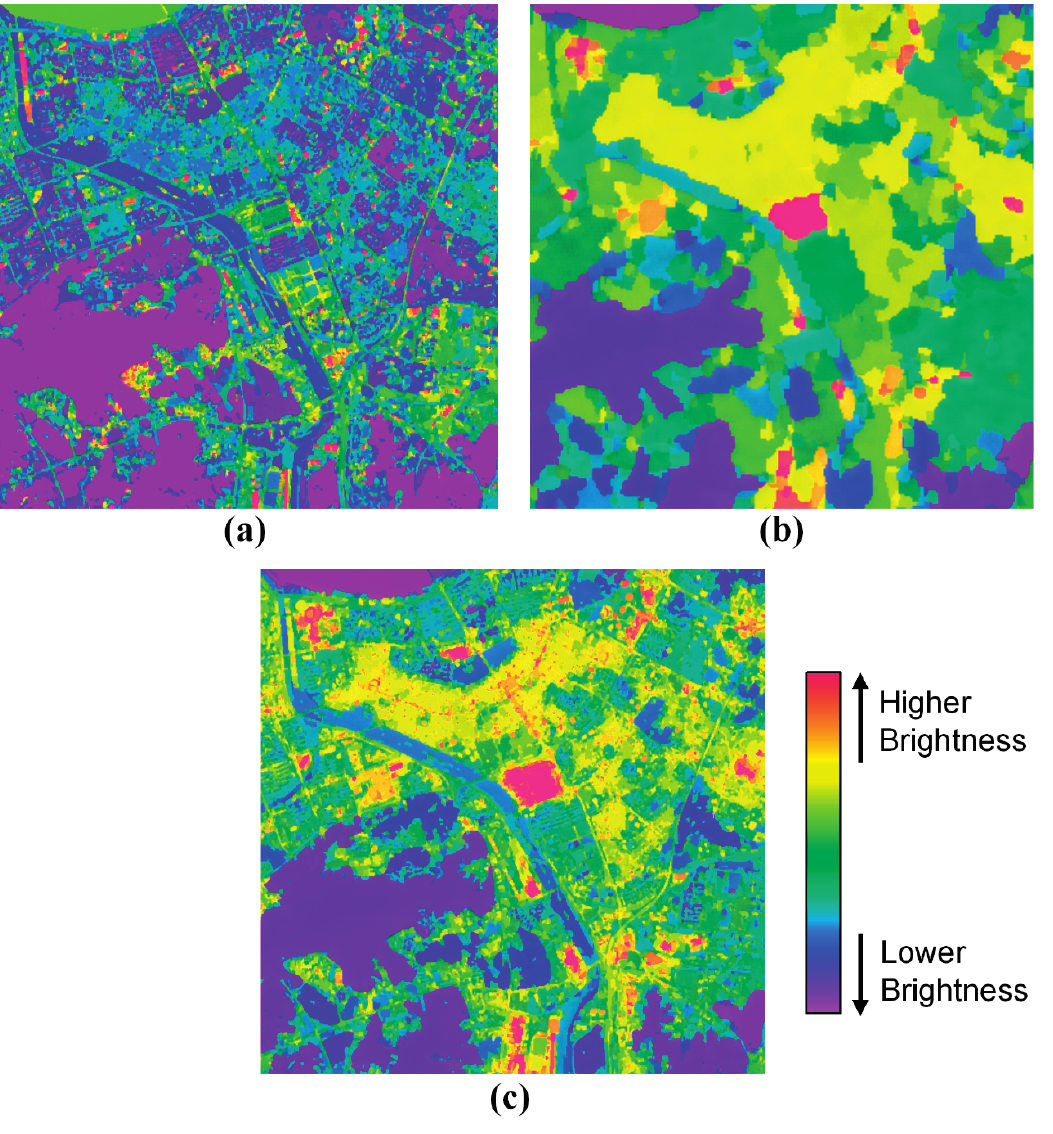
Figure 9. Image segmentation results from ( a ) the PAN image; ( b ) the TIR image and ( c ) the fused image of Figure 8 using the watershed